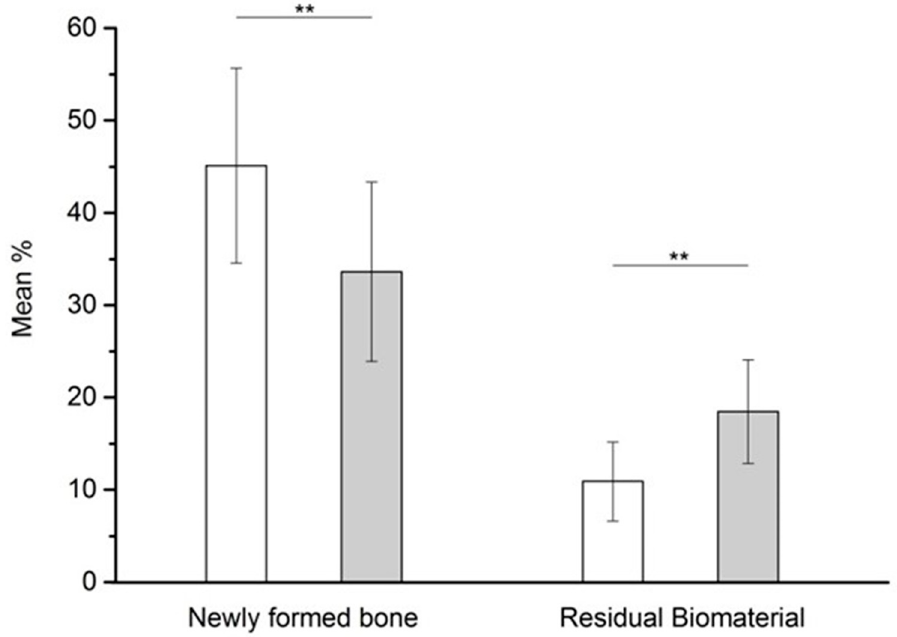
Table 1. Summary of data and results of the present study.